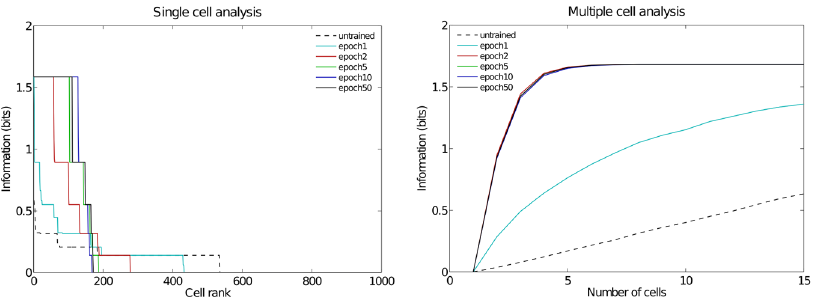
Figure 6. Information analysis for different degrees of training. Analysis of the information about where the target object is with respect to the hand conveyed by the output (fourth) layer neurons for six degrees of training: untrained, 1 epoch, 2 epochs, 5 epochs, 10 epochs, and 50 epochs. The left plot shows the amount of single cell information carried by individual output cells in rank order. After the second epoch it was found that 57 cells reached the maximum amount of single cell information of 1.58 bits. The multiple cell information asymptotes to the maximal value of 1.58 bits after the second epoch. This confirms that all three hand-object configurations are represented by the output cells.